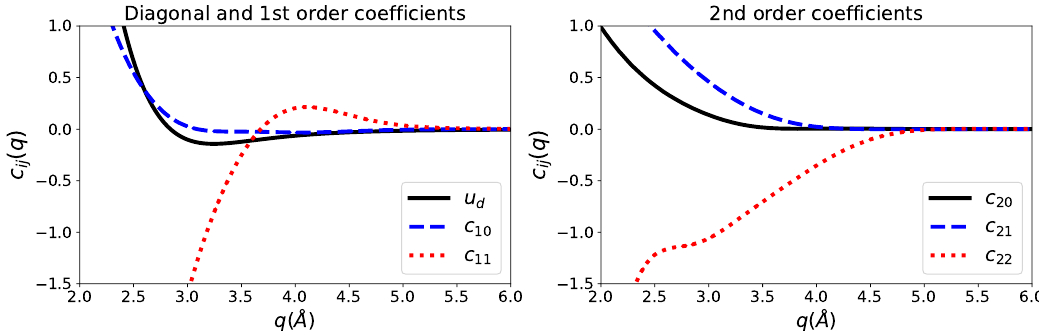
Figure 3: Diagonal pair action (black solid line, left panel), first-order coefficients (left panel), and second-order coefficients (right panel) of Eq. (48) for a pair 3 He atoms interacting via the Aziz potential [ 65 ] at temperature T = 50 K obtained from six numerical convolutions of a short imaginary time WKB expression [ see Eq. (33) ]